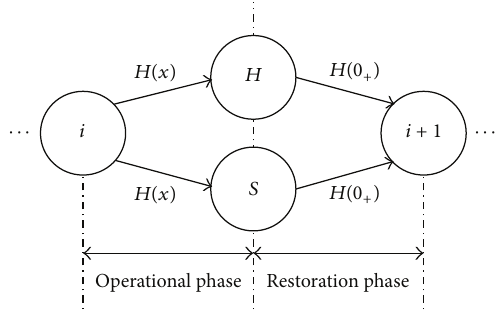
Figure 2: Power consumption for an instance lifetime of the